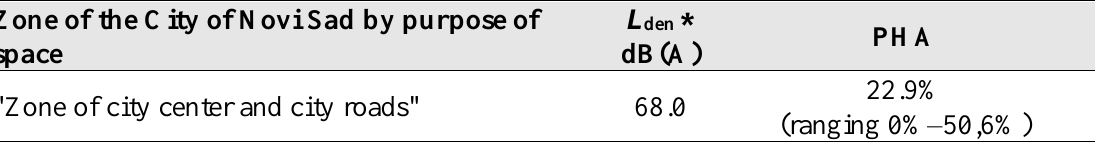
Table 4. Determination of prevalence of Novi Sad human population highly annoyed by methodology according to ISO 1996-1: 2016.